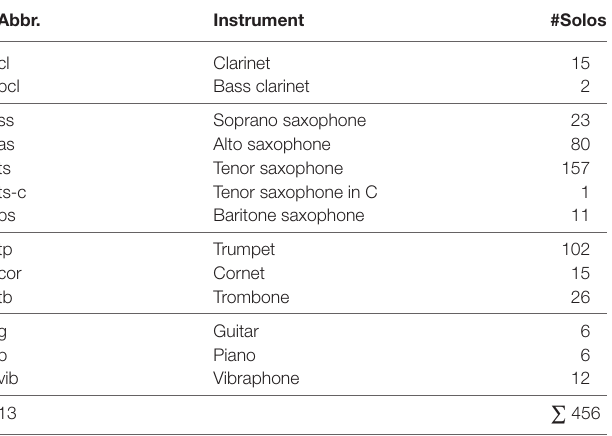
TaBle 1 | Solo instruments occurring in the